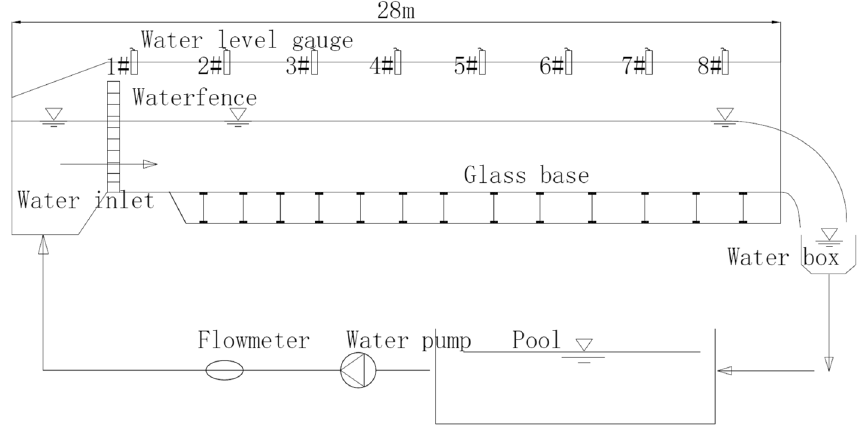
Fig. 4 Schematic diagram of the 28-m variable-slope